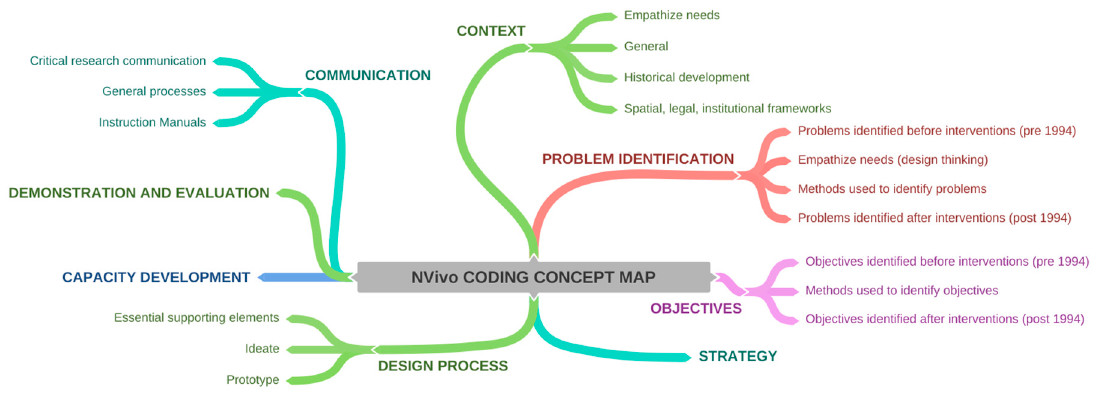
Figure 2. Concept map of coding in NVivo.